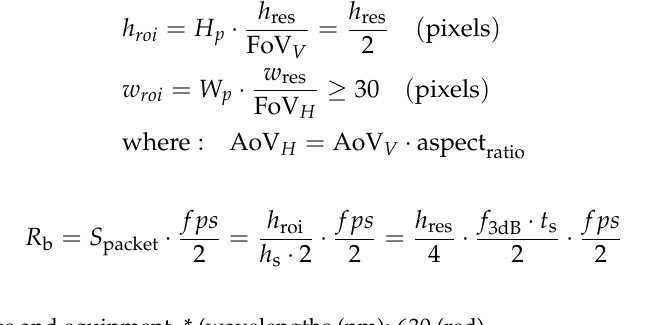
Table 1. Resources and equipment. * (wavelengths (nm): 630